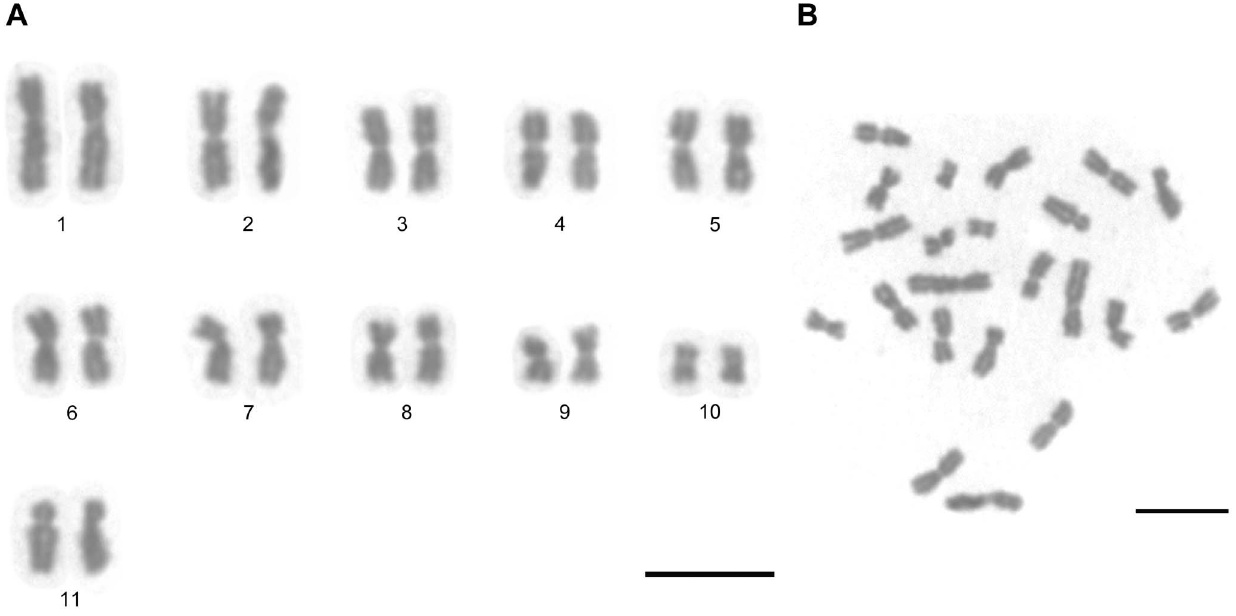
Figure 1. Conventional staining of mitotic cells of Acromyrmexstriatus. ( A ) Diploid karyotype 2n=22 and ( B ) its metaphase. Scale bar=5 m m.